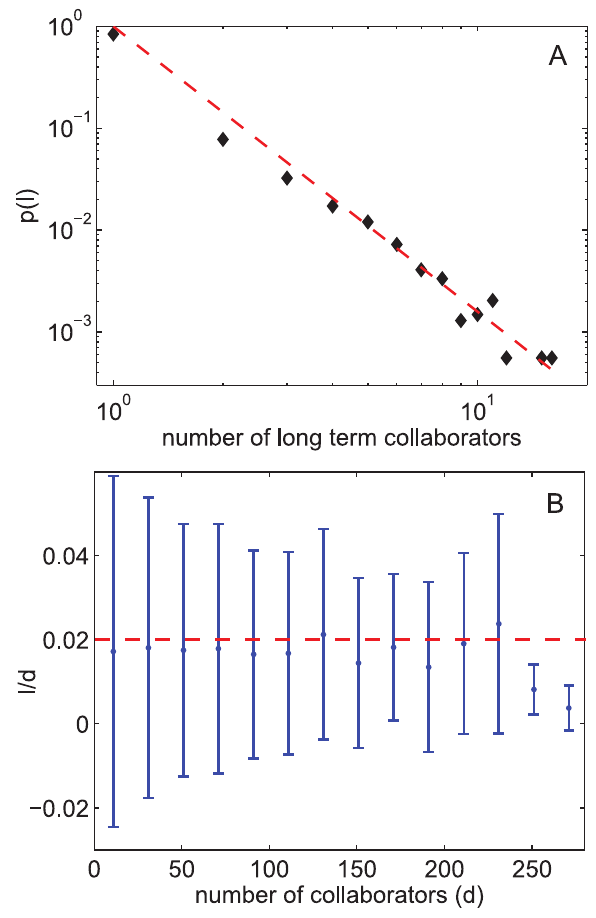
Figure 2. Statistics of long term scientific collaborations. (A) The probability distribution p ( l ) of number of long term collaborations l { 1 a scientist can have. The average number of long term collaborations the 5000 selected scientists have is 0.73. Most of the scientists do not have long term collaborations with peer researchers. The dashed line is a power law with exponent 2 2.4. (B) The correlation between the a scientist’s number of collaborators d and probability of having long term collaborators (denoted by the proportion of long term ones in all the collaborators l = d ). Each point on the graph shows the average l = d ratio of scientists with d + 10